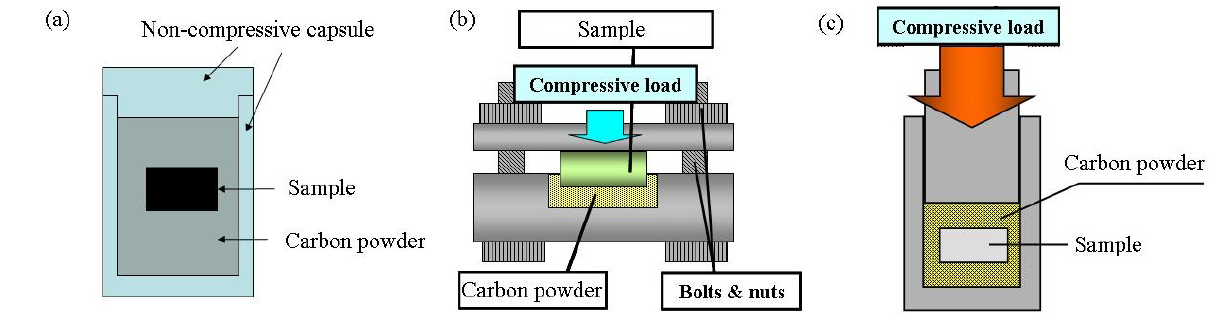
Figure 5. Apparatuses used in previous carburization